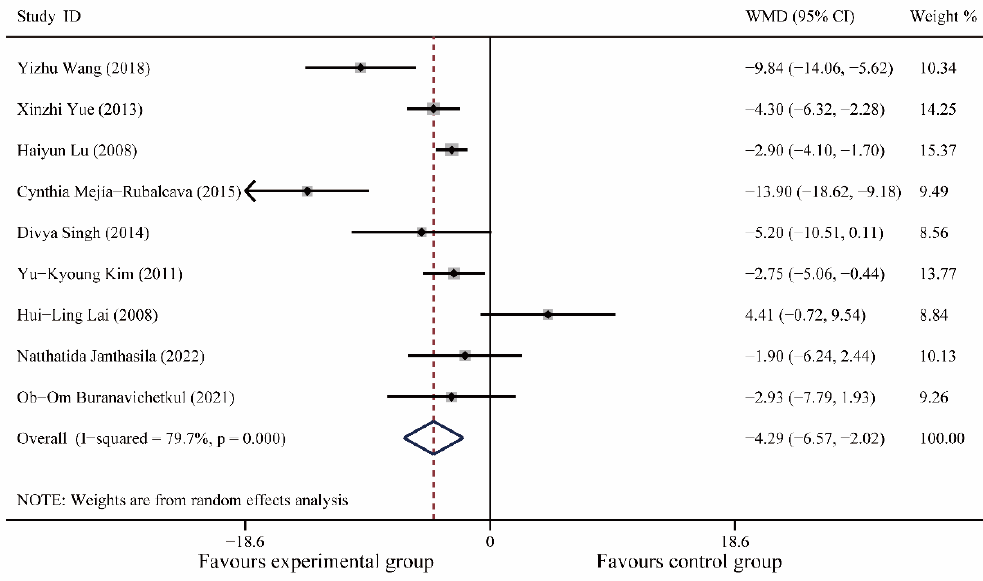
Figure 5. Forest plot of postoperative diastolic blood pressure [20,21,24 – 27,29,30,34].